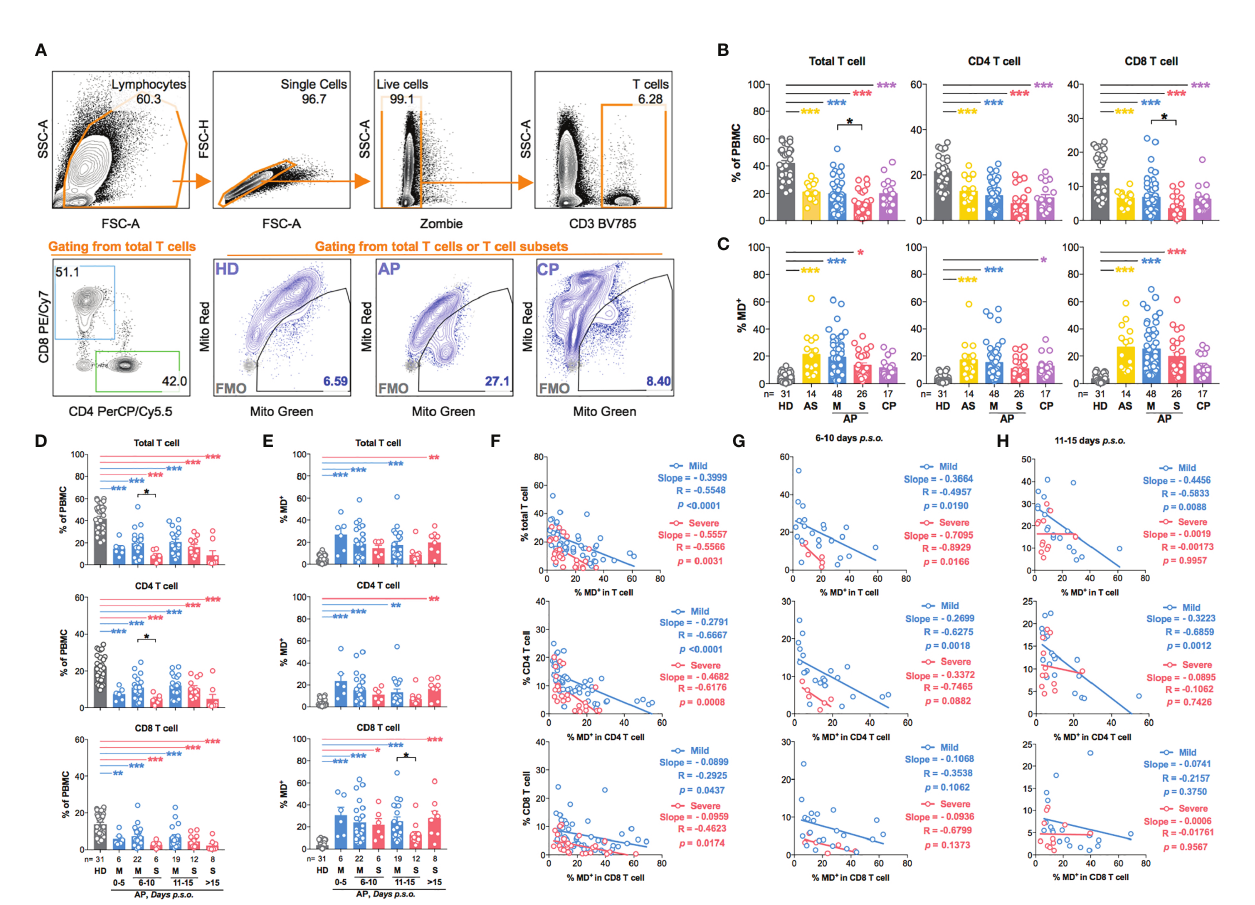
FIGURE 1 | T-cell subsets in asymptomatic and symptomatic donors are characterized by increased production of dysfunctional mitochondria during SARS-CoV-2 acute infection. Fresh peripheral blood mononuclear cells (PBMCs) of 88 SARS-CoV-2 acute patients (APs), 17 convalescent patients (CPs), and 31 healthy donors (HDs) were collected and pro fi led using fl ow cytometry in at least three independent experiments. (A) Representative plots showed the gating strategy on different T- cell subsets and cells with mitochondrial dysfunction (MD + ) based on fl uorescence minus one (FMO) control in FACS analysis. (B) The frequency of total T cells, CD4 T cells, and CD8 T cells and (C) the percentage of MD + cells in total T cells, CD4 T cells, and CD8 T cells were compared among different groups based on disease severity compared to HDs and CPs. For symptomatic patients, (D) the frequency of total T cells, CD4 T cells, and CD8 T cells and (E) the percentage of MD + cells in total T cells, CD4 T cells, and CD8 T cells along disease development were compared between mild and severe APs. HDs (in gray) served as negative control. Data represent mean ± SEM. Statistics were calculated based on one-way ANOVA test. * p < 0.05, ** p < 0.01, *** p < 0.001. (F) The correlation between cell frequency and the percentage of MD + cells in T-cell subsets from mild or severe APs during all time periods was calculated by Pearson ’ s correlation coef fi cient analysis. The correlation between cell frequency and the percentage of MD + cells in T-cell subsets from mild or severe APs during the period of 6 – 10 days (G) or 11 – 15 days (H) post symptom onset (p.s.o.) was also calculated by Pearson correlation coef fi cient